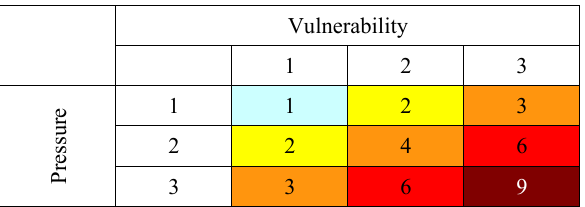
Table 2. Matrix of risk